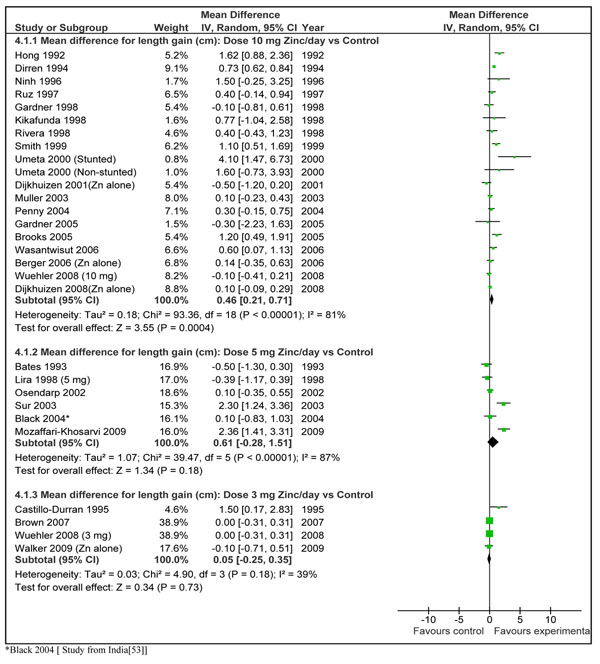
Forest plot for mean gain in height (cm) after zinc supplementation alone in children less than 5 years of age: Subgroup analysis according to different dosages